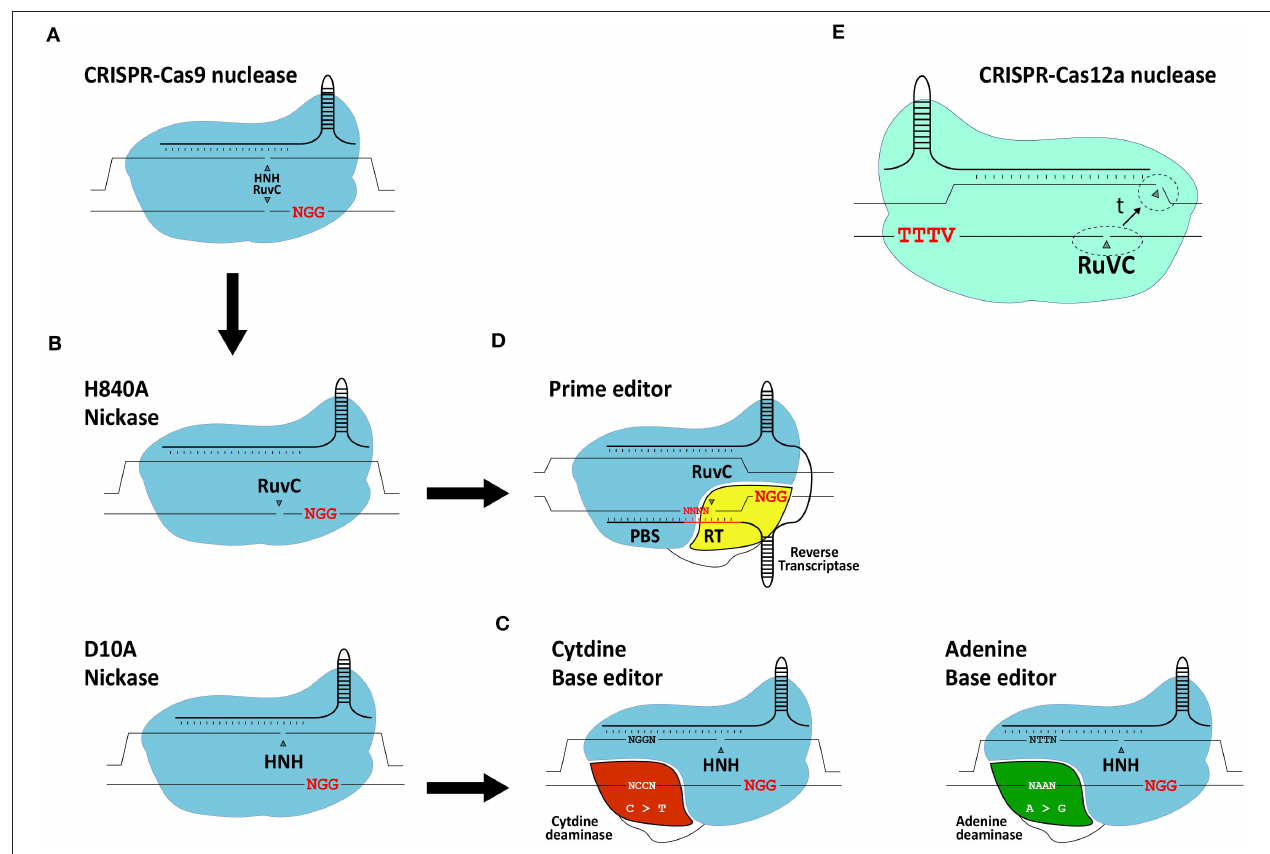
FIGURE 5 | Schematic representation of gene editing tools based on CRISPR systems. (A) RGN based on the prototypic S. pyogenes CRISPR-Cas9 system. (B) RGNs containing the sequence- and strand-specific nuclease (nickase) Cas9 H840A or Cas9 D10A . (C) Base editors. The basic components of base editors consist of a nickase (typically S. pyogenes Cas9 D10A ) fused to a cytidine deaminase or engineered adenine deaminase. (D) Prime editors. The basic components of prime editors consist of a nickase (typically S. pyogenes Cas9 H 840 A ) linked to an engineered reverse transcriptase. (E) RGN based on a CRISPR-Cas12a system. Cas12a has a single RuvC-like domain responsible for staggered DNA end formation from the sequential cleavage of both target site strands (dashed circles: location of cleavage; t: time). Red letters; protospacer adjacent motifs.